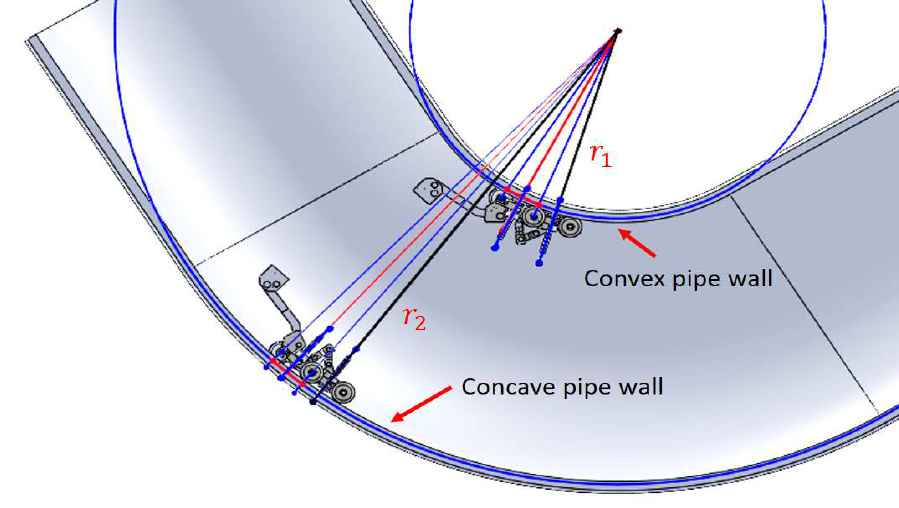
Figure 9. Sensor carriers inside concave and convex pipe elbow